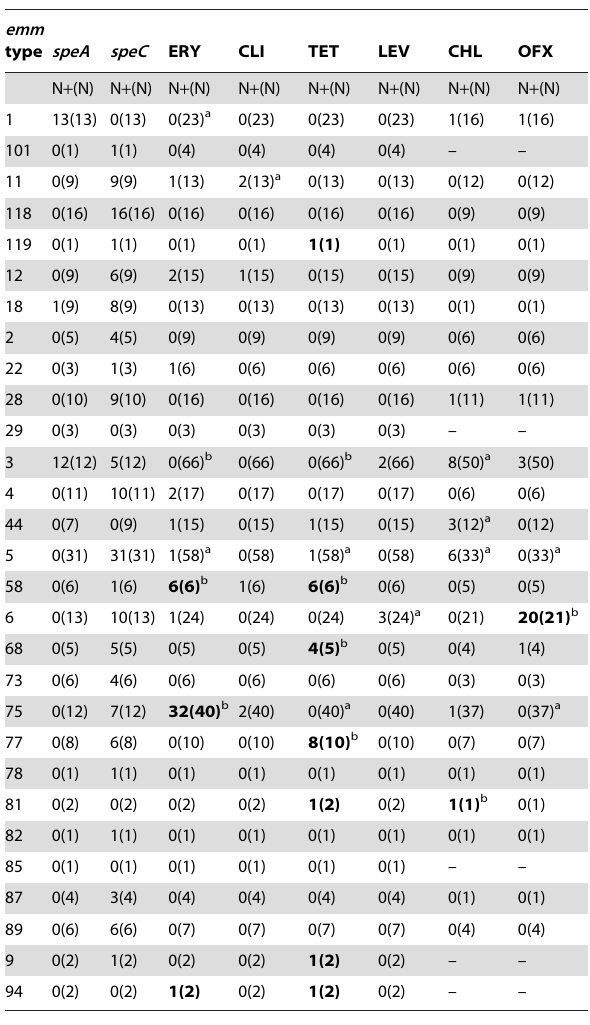
Table 3. Isolate properties by sequenced emm